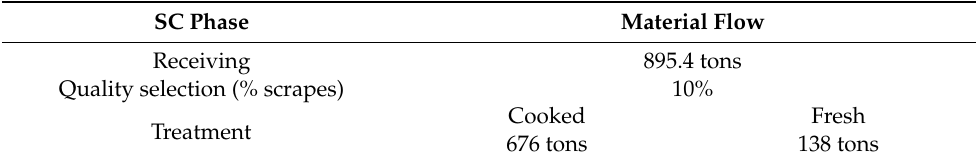
Table 3. Material flow in the observed chestnut